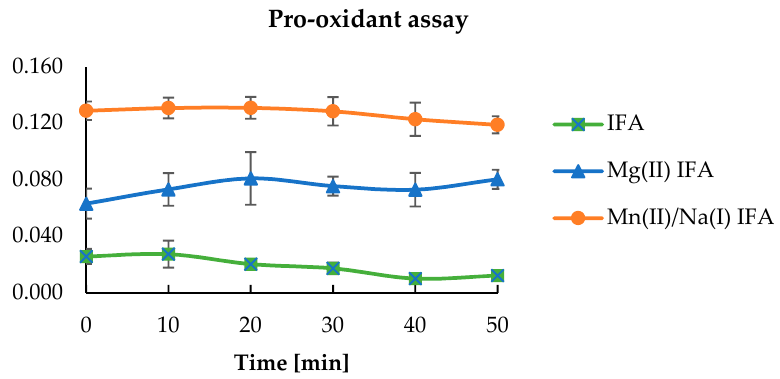
Figure 8. A comparison of the absorbance (at 272 nm) of Trolox quinone (concentration of tested compounds 0.5 mM) at time 0 in the pro-oxidant assay.